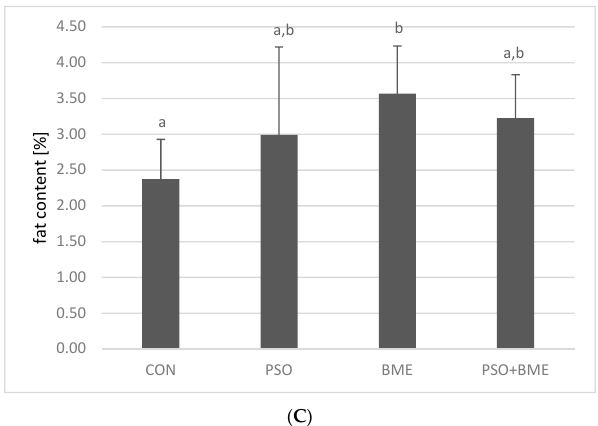
Figure 2. Liver mass ( A ), relative liver mass ( B ) and fat content [%] ( C ) in rats of experimental groups. CON—control group; PSO—group receiving PSO in the amount of 0.15 mL/day; BME—group receiving BME ad libitum; PSO + BME—group receiving PSO in the amount of 0.15 mL/day and BME ad libitum. All data are shown as mean values ± standard deviation of data obtained from all animals ( n = 12) in each group. Values with a different letter index are significantly different from each other ( p ≤ 0.05) in post-hoc RIR Tukey test.